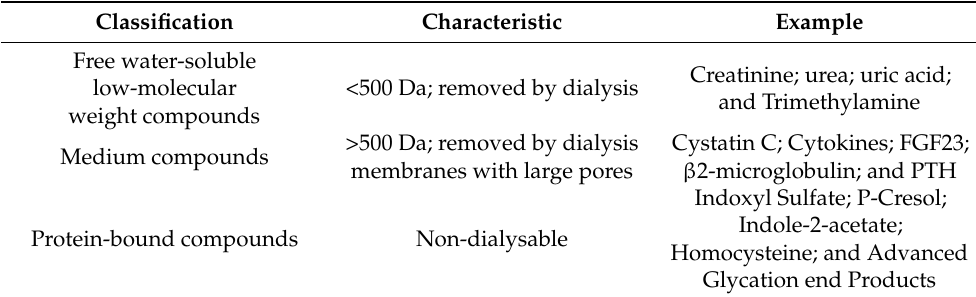
Table 2. Physicochemical characteristics for uremic toxin classification. Classification